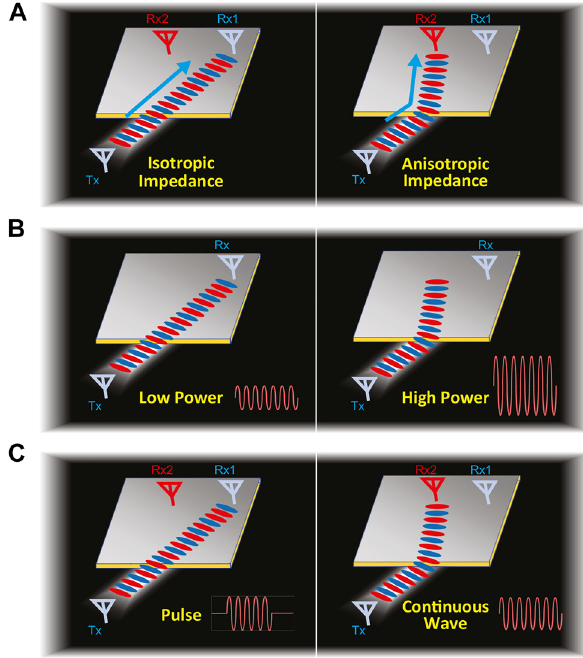
Figure 1: Isotropic and anisotropic surface response along with the applications of a switchable anisotropic impedance surface with power or waveform